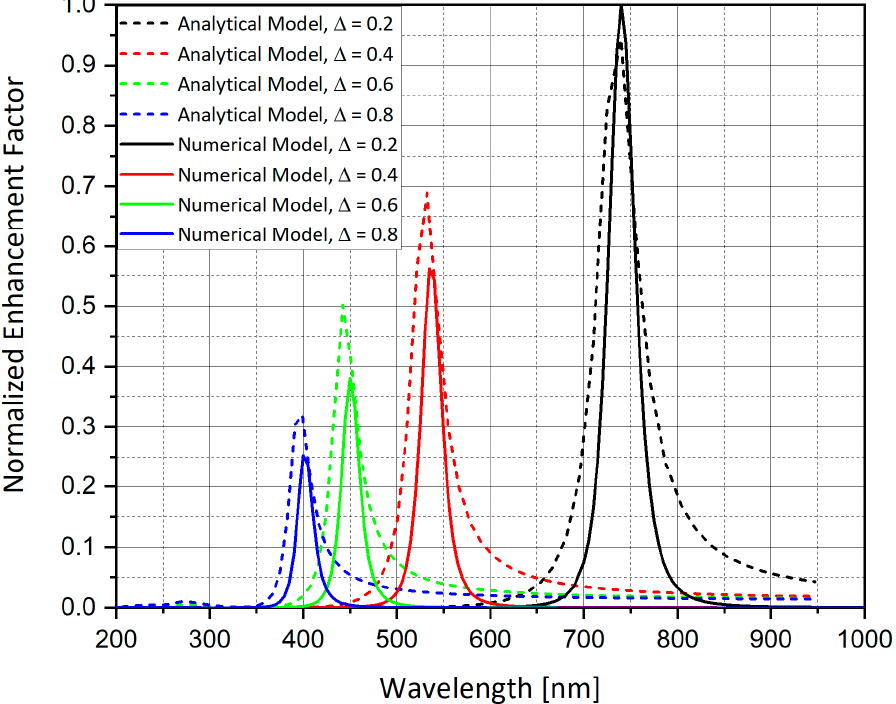
Figure 18. Analytical and numerical models for the normalized enhancement factor.